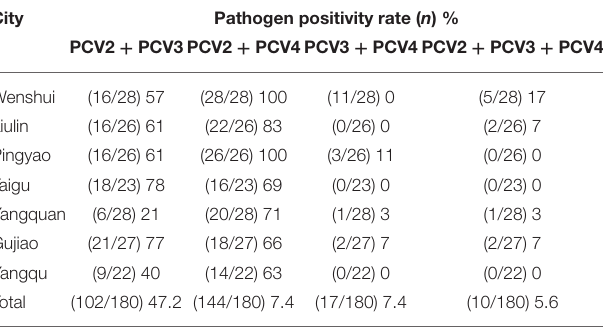
TABLE 3 | Co-positivity rate of PCV2, PCV3, and PCV4 in central Shanxi Province. City